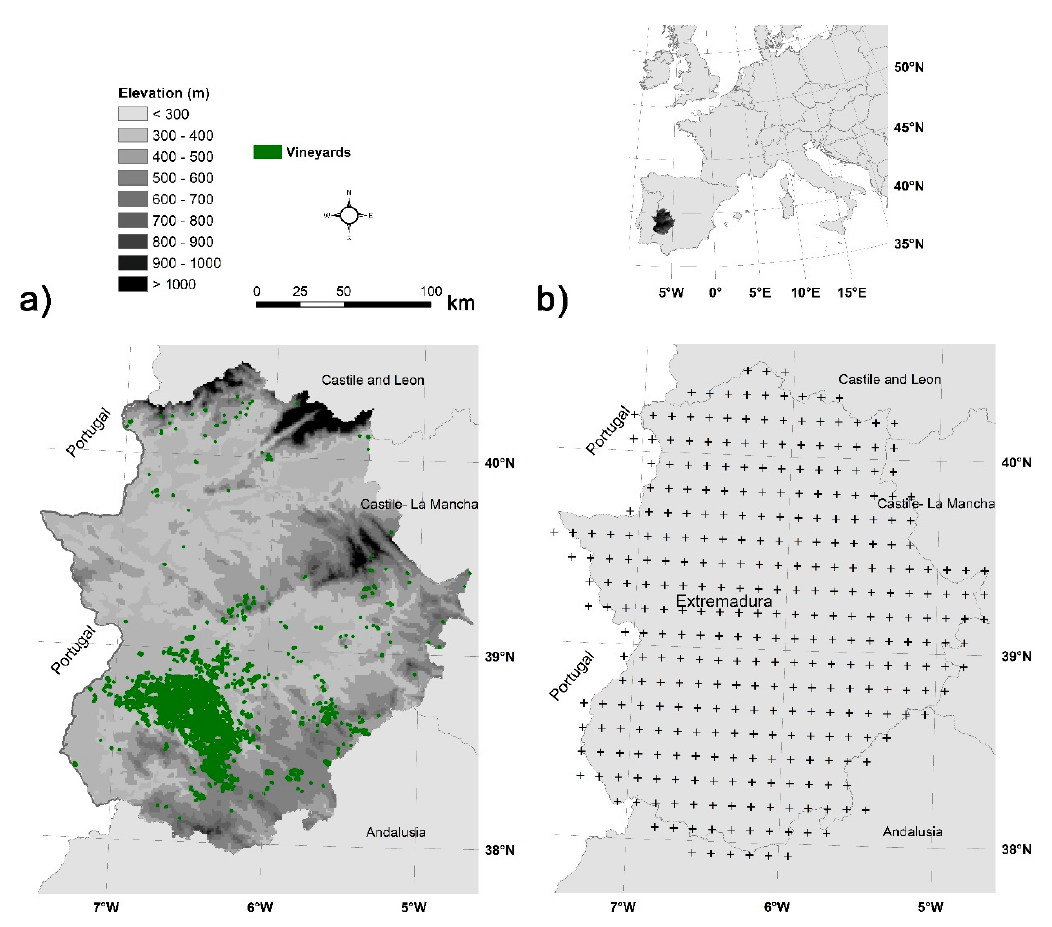
Figure 1. Location map of Extremadura. Digital elevation models and vineyards in Extremadura are shown ( a ). Grid points where climate variables were available and considered to calculate bioclimatic indices are indicated as crosses ( b ).